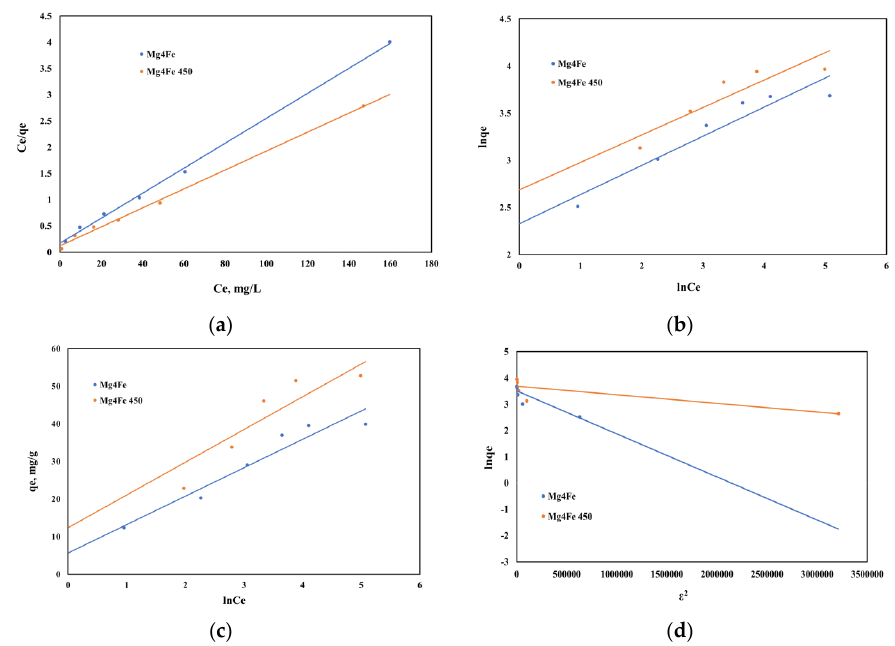
Figure 4. Equilibrium isotherms of Mo(VI) adsorption onto the studied adsorbent: ( a ) Langmuir, ( b ) Freundlich, ( c ) Temkin, and ( d ) Dubinin–Radushkevich.